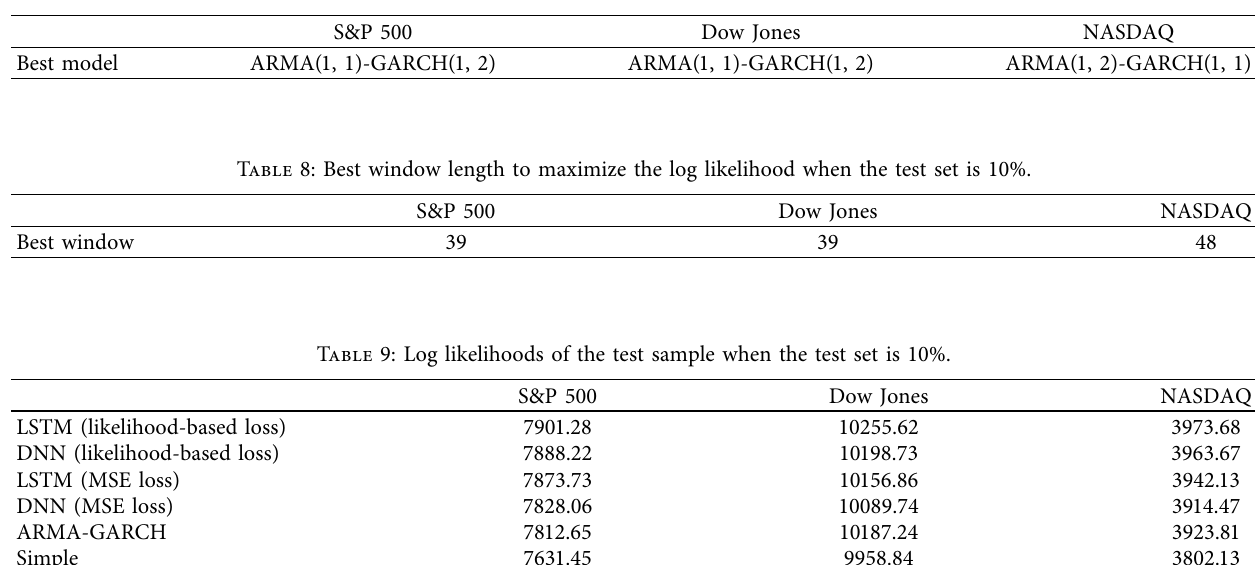
Table 7: ARMA-GARCH model with minimum BIC when the test set is 10%.